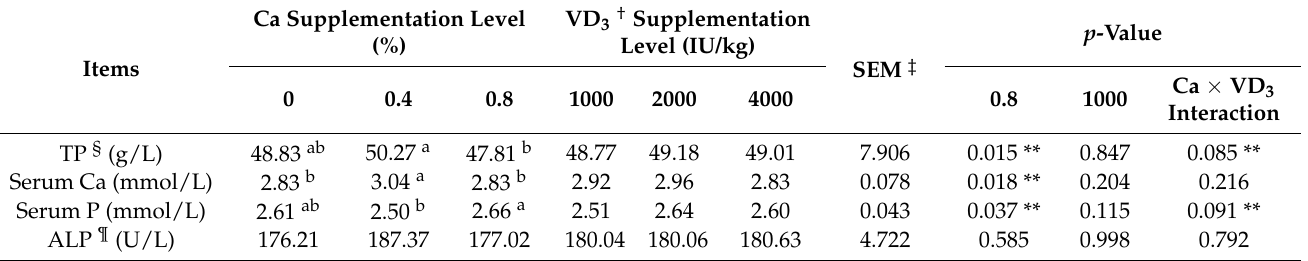
Table 6. Effects of dietary Ca and VD 3 supplemental levels on serum biochemical indices in growing blue foxes (LS means ±